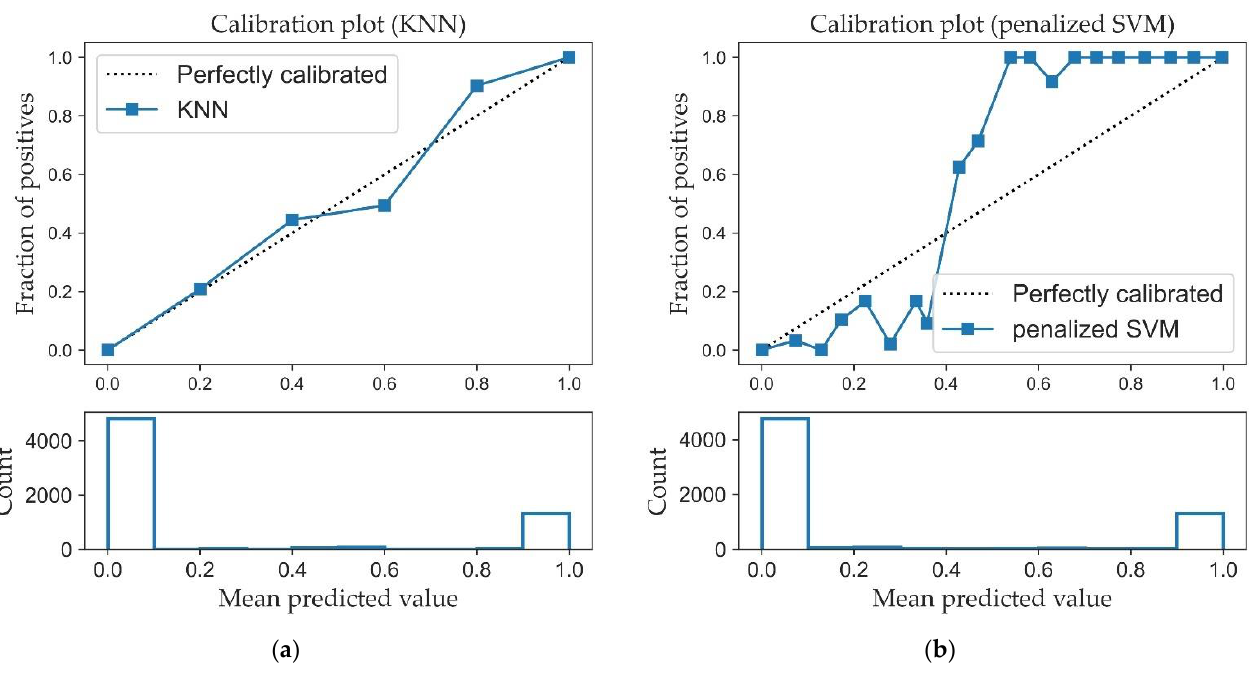
Figure 20. Calibration for ( a ) KNN and ( b ) SVC Models.